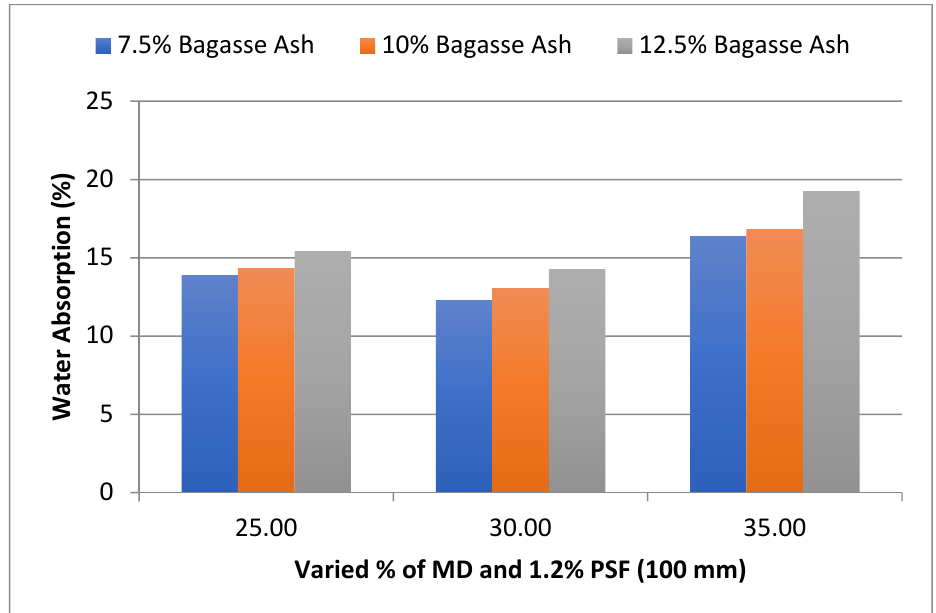
Figure 7. Effect of MD and BA on water absorption of block reinforced with 1.2% PS fiber (100 mm).